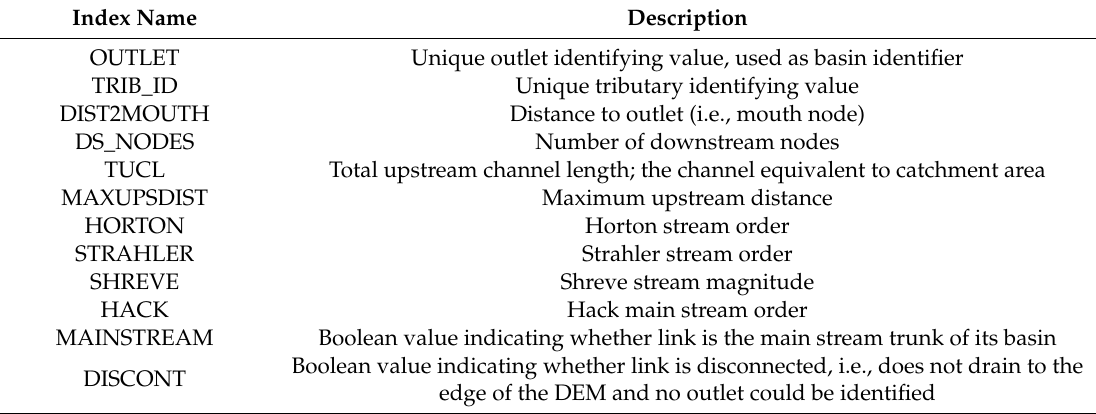
Table 1. Calculated drainage network analysis outputs, including their abbreviated names as they appear in the output stream layer’s attribute